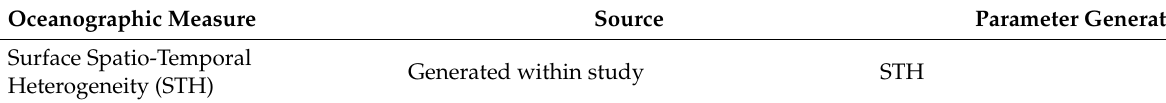
Table 1. Input parameters, and source datasets for STH output